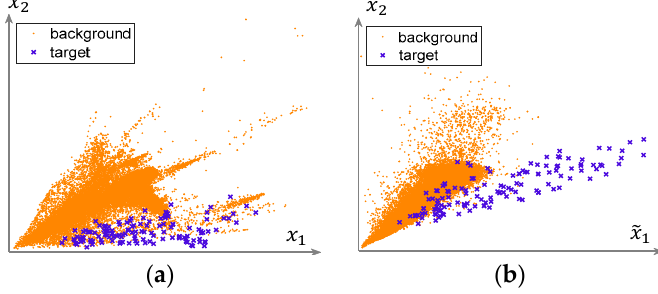
Figure 4. Illustration of the difference of the angle distance before and after the adaptive whitening transformation; ( a ) is in the original data space, ( b ) is in the whitened data space.